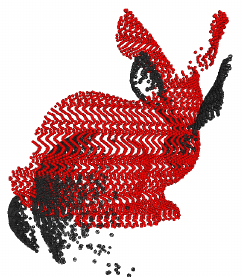
Fig. 9: Best registration (ICP CTSF, with k = 75% ) obtained for the 90 ◦ - 180 ◦ case. All the registration methods of Section III get incorrect results in this Fig. 7: Rotation error for the registration techniques (Trimming 90 ◦ , computed using parameter τ = 0 ), for the case 45 ◦ − metric: (a) φ 1 . (b) φ 3 ; (c) φ 4 ; (d) φ 5 .